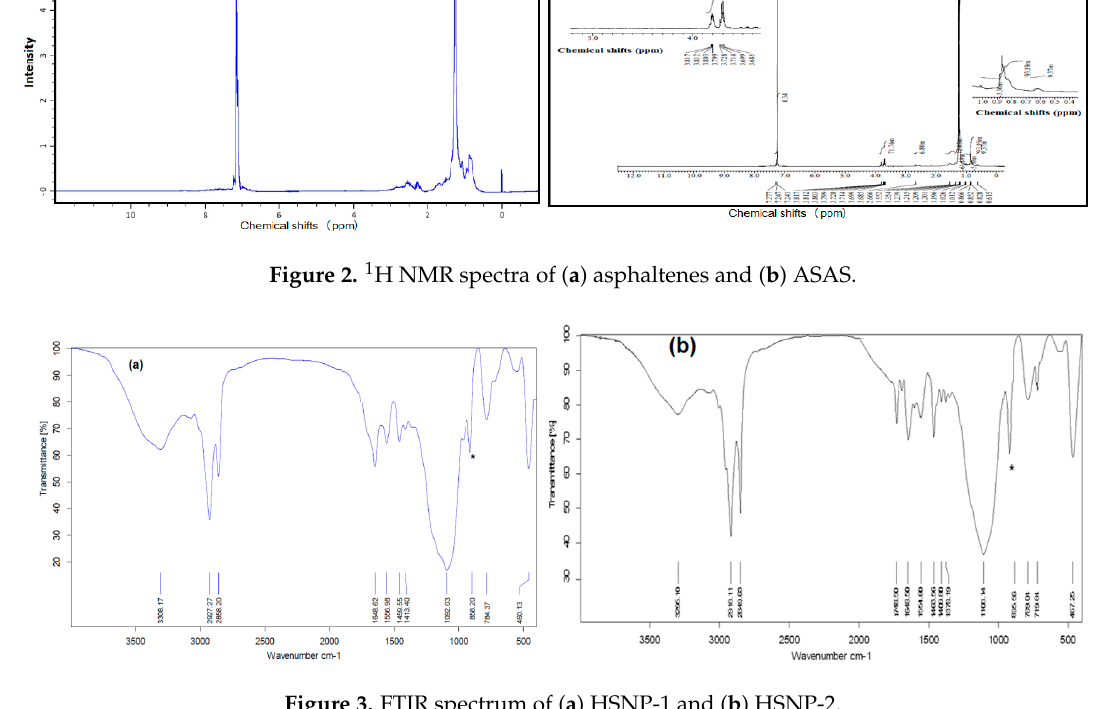
Figure 3. FTIR spectrum of a ) HSNP-1 and b ) HSNP-2.